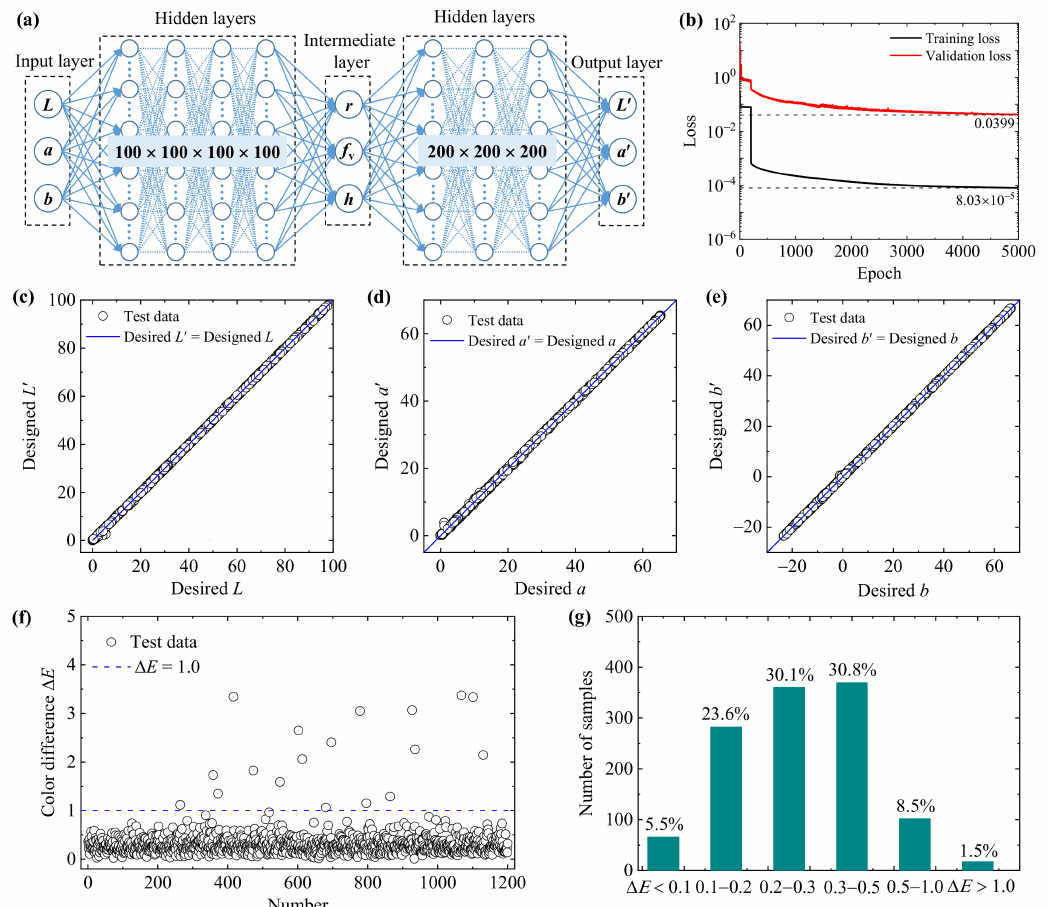
Figure 7. The bidirectional neural network for designing the geometric parameters of gold nanoparticle systems. ( a ) Struc- ture of the multilayered BNN. ( b ) The loss functions of the training and validation sets. ( c – e ) Scatter plot of the desired colors ( L , a , b ) and predicted colors ( L (cid:48) , a (cid:48) , b (cid:48) ) for the 1200 groups of test data. ( f ) The color differences ∆ E between the designed colors and desired colors. ( g ) Statistical distributions of the testing results divided by different ranges of color